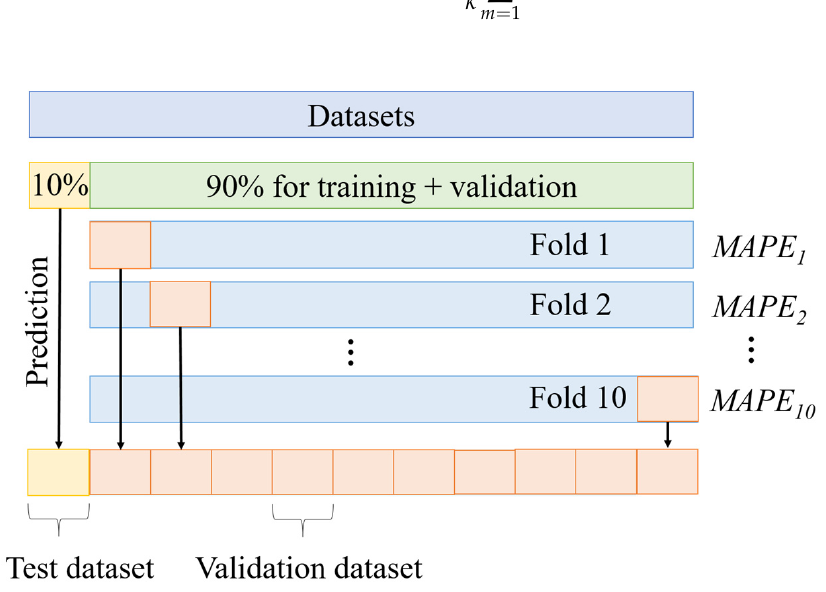
Figure 6. Schematic of k -fold cross-validation procedure ( k = 10).